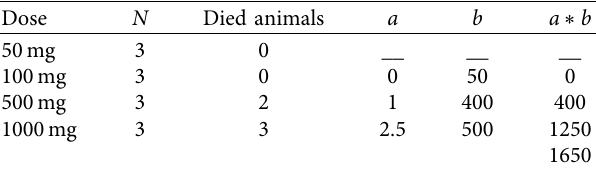
Table 3: The changes in rats’ weights during the period of acute toxicity experiment.